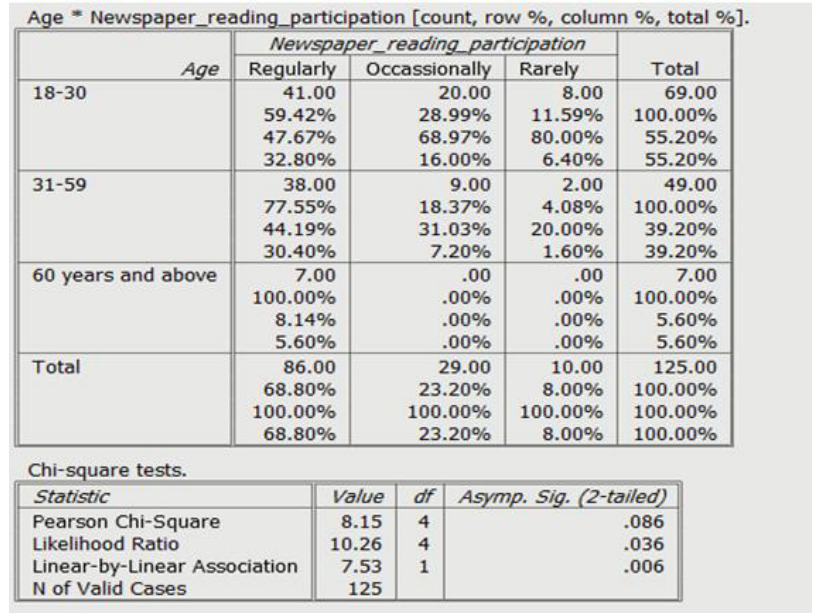
Figure 4: Cross Tabulation and Chi-square between Age v/s Newspaper Reading Participation (Source: Authors‟